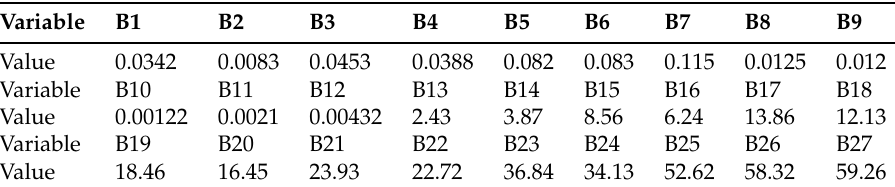
Table 4. Optimal membership function parameter values.